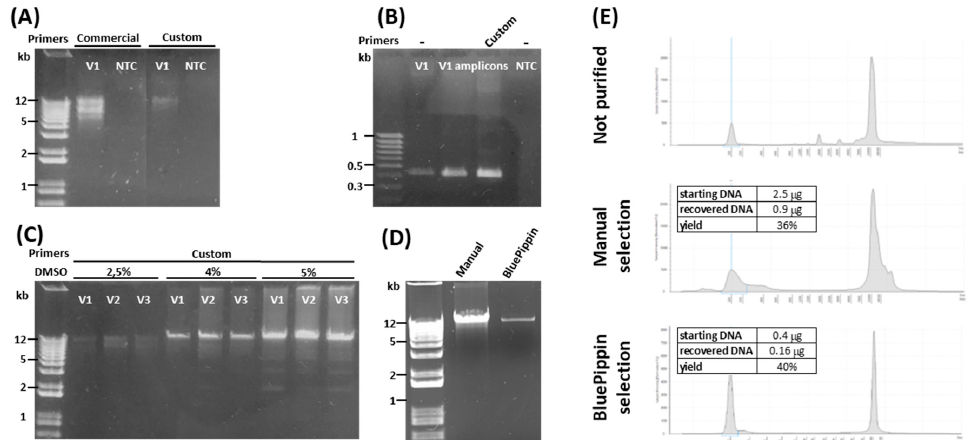
Figure 2. Amplification of the APOE locus. ( A ) Agarose gel electrophoresis of amplicons generated from sample V1 genomic DNA using LongAmp Taq Polymerase (NEB) and commercial primers (Qiagen) or custom primers. The expected amplicon size is ~12 kb. ( B ) Agarose gel electrophoresis of amplicons generated from sample V1 genomic DNA or from PCR products (V1 amplicons) generated in ( A ), using nested primers designed to amplify a 412-bp product from APOE exon 3. ( C ) Agarose gel electrophoresis of long-range PCR amplicons generated using custom primers in the presence of 2.5%, 4%, or 5% DMSO. ( D ) Agarose-gel electrophoresis of amplicons generated using custom primers and 4% DMSO and further selected by gel excision and on-column purification (manual) or the BluePippin device. ( E ) Capillary electrophoresis of the same products from ( D ). Starting and recovered µ g refer to the amount of amplicon before and after size selection and the relative yield. NTC = no-template